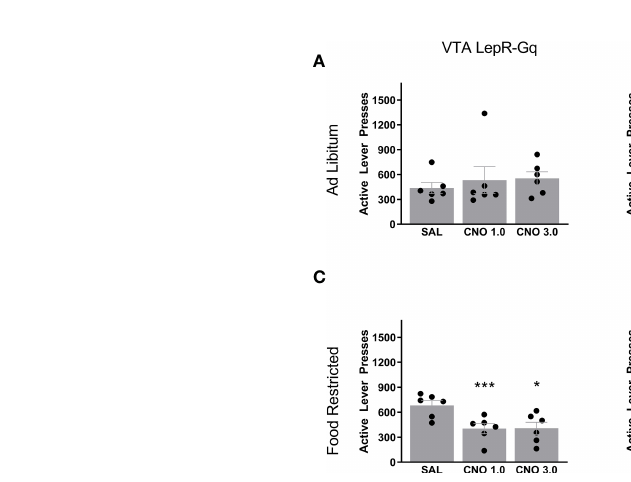
FIGURE 5 | Active lever presses upon chemogenetic activation of VTA LepR or SN LepR neurons. In ad libitum fed mice, CNO (1.0 and 3.0mg/kg) did not affect active lever presses made in (A) VTA LepR-Gq (n=6) or (B) SN LepR-Gq mice (n=6). (C) Food restricted VTA LepR-Gq mice (n=6) decreased active lever presses after CNO compared to saline injections. (D) CNO did not affect active lever presses in food restricted SN LepR-Gq mice (n=6). Mean ± SEM. *p<0.05,